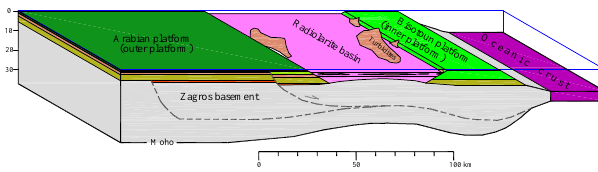
Figure 4. Sedimentary basins across the northeastern margin of the Arabian Plate in the Turonian (Late Cretaceous), just before the ob- duction of the oceanic